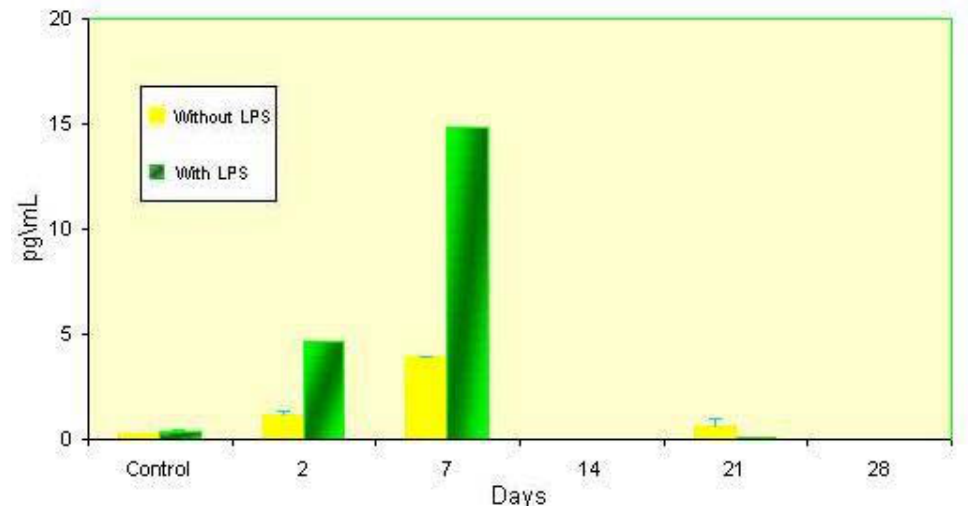
Figure 5. Levels of TNF- α produced by macrophages from BALB/c mice in the absence or presence of LPS in 48h-incubation culture. Values were expressed as